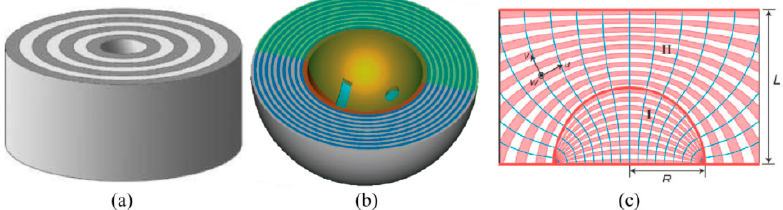
Figure 22. Schematic structures of variant hyperlenses with metal-dielectric films in ( a ) circular cylinder; ( b ) spherical form; ( c ) complex transformed coordinates. Reproduced from: (a), [91], Copyright © 2006, OAS; (b), [92], Copyright © 2010, NPG; (c), [93], Copyright © 2008,